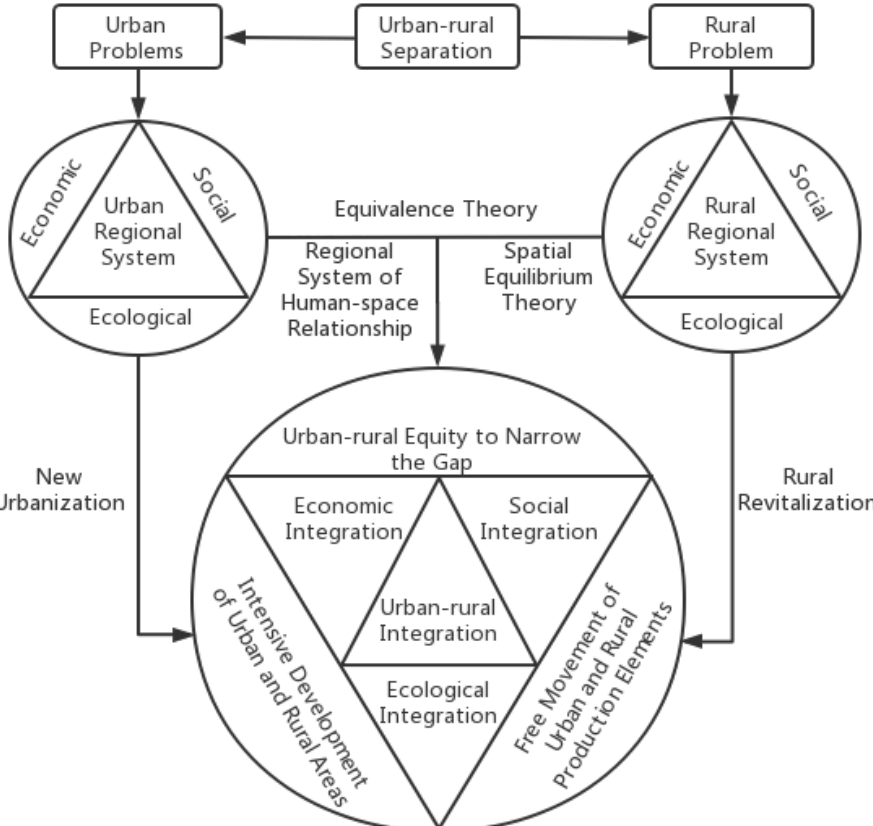
Figure 1. Theoretical Framework Diagram.